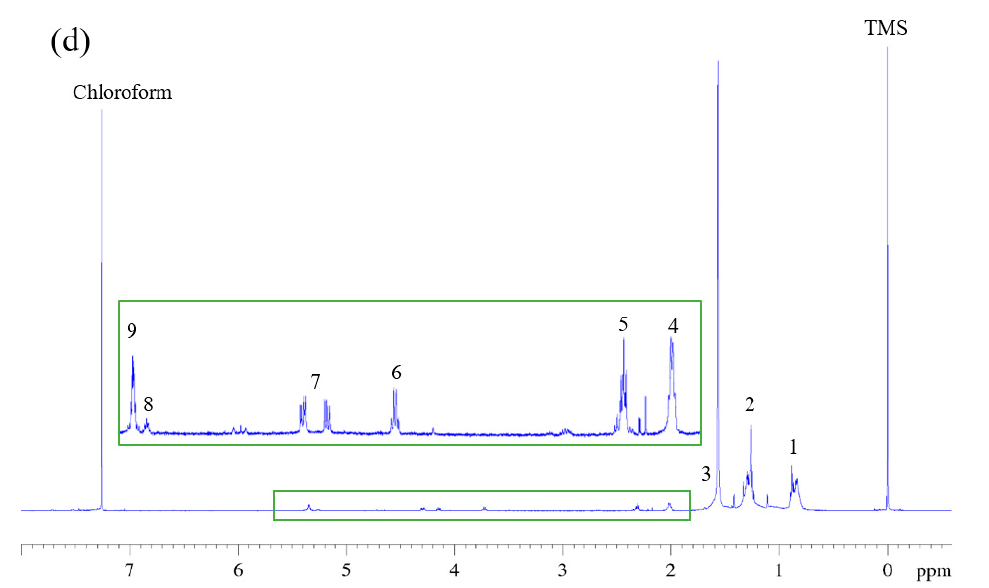
Figure 4. 1 H ‐ NMR spectra obtained at 500 MHz of ( a – c ) the aqueous phase of Tacle juice divided into three regions (see Supplementary Material, Table S1 for assignment) and ( d ) lipophilic Tacle extract. Table 1. 1 H ‐ NMR peak assignment of a typical lipid extract from Tacle juice. Peak labels (1 to 9) agree with those given in Figure 4d.